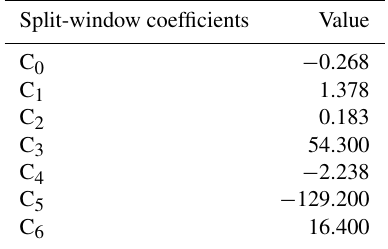
Table 4. Split-window coefficient values (Skokovic et al., 2014). Split-window coefficients Value